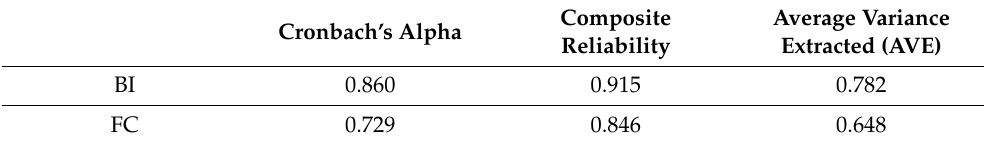
Table 3. Reliability and convergent validity